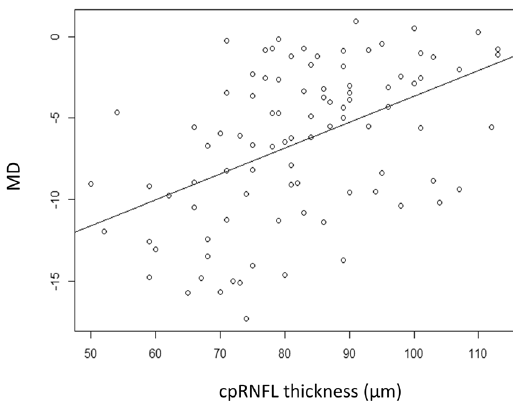
Figure 3. Relationship between the mean deviation (MD) and the circumpapillary retinal nerve fiber layer (cpRNFL) thickness. A significant relationship was observed between the MD and the cpRNFL